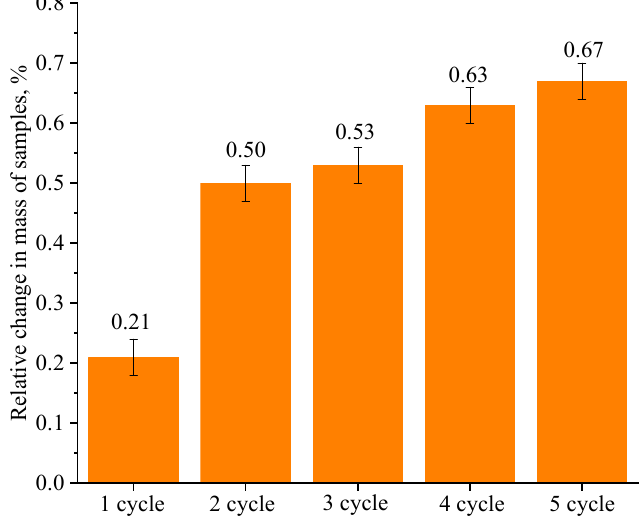
Figure 7. Relative change in the mass of ABE wire samples treated with SiO 2 nanoparticles sol.